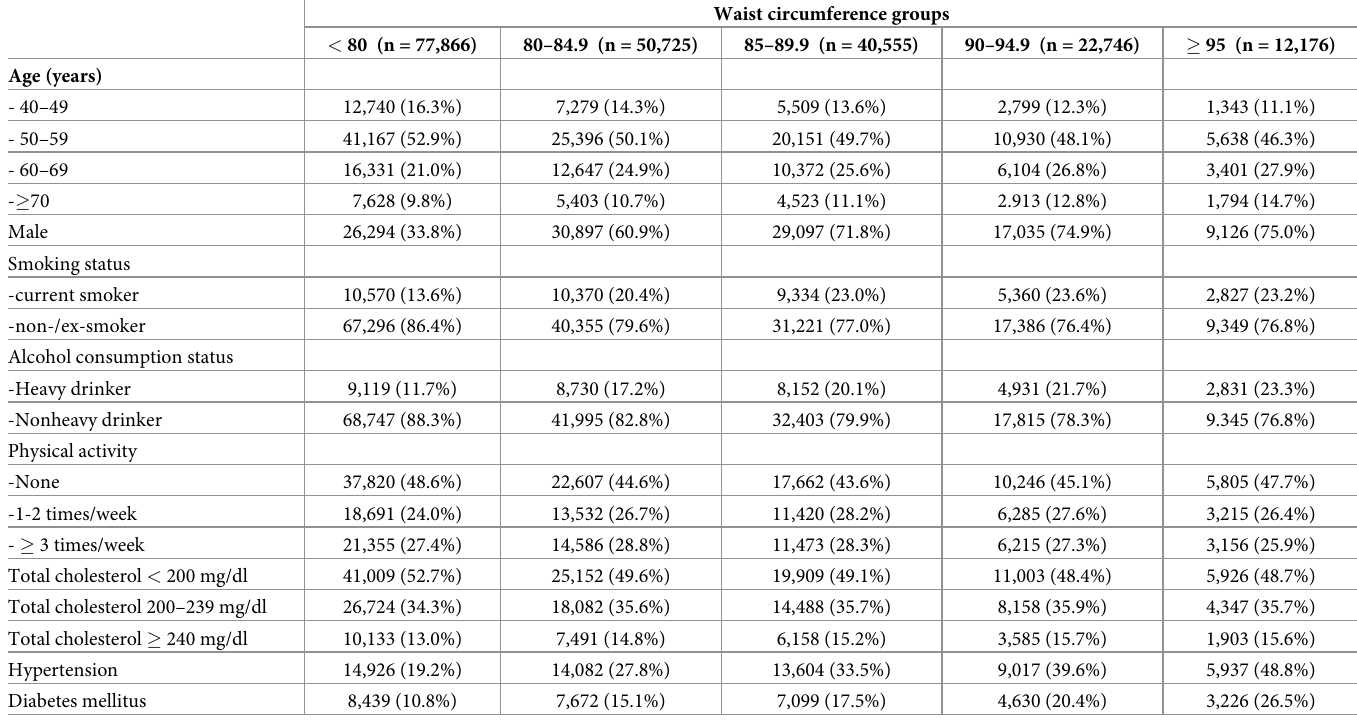
Table 1. Demographic and clinical characteristics of the subjects according to waist circumference categories.